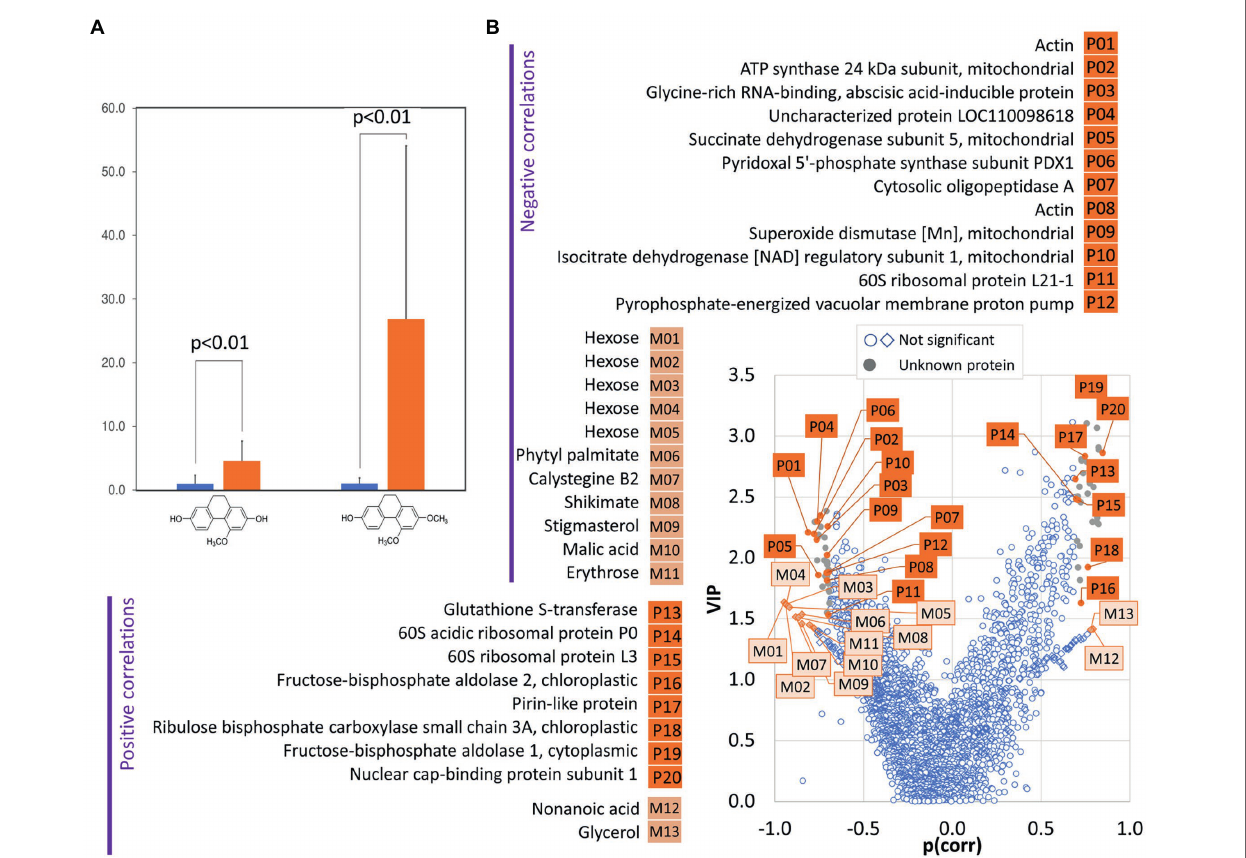
FIGURE 6 | The amount of dihydrophenanthrene correlates with changes in protein and metabolites in tubers of inoculated orchids. (A) Relative dihydrophenanthrene content in inoculated (orange) and mock-treated (blue) orchid tubers. Data represent the means and standard deviation of at least four biological replicates (tubers of four inoculated plants and five mock-treated controls). The coelonin and orchinol content was normalized to the coelonin content in mock-treated tubers. Statistically significant differences (Student’s t -test) are indicated. (B) Identification of proteins (P) and metabolites (M) correlating with dihydrophenanthrene pool in tubers by orthogonal partial least squares discriminant analysis followed by VIP (variables of importance in